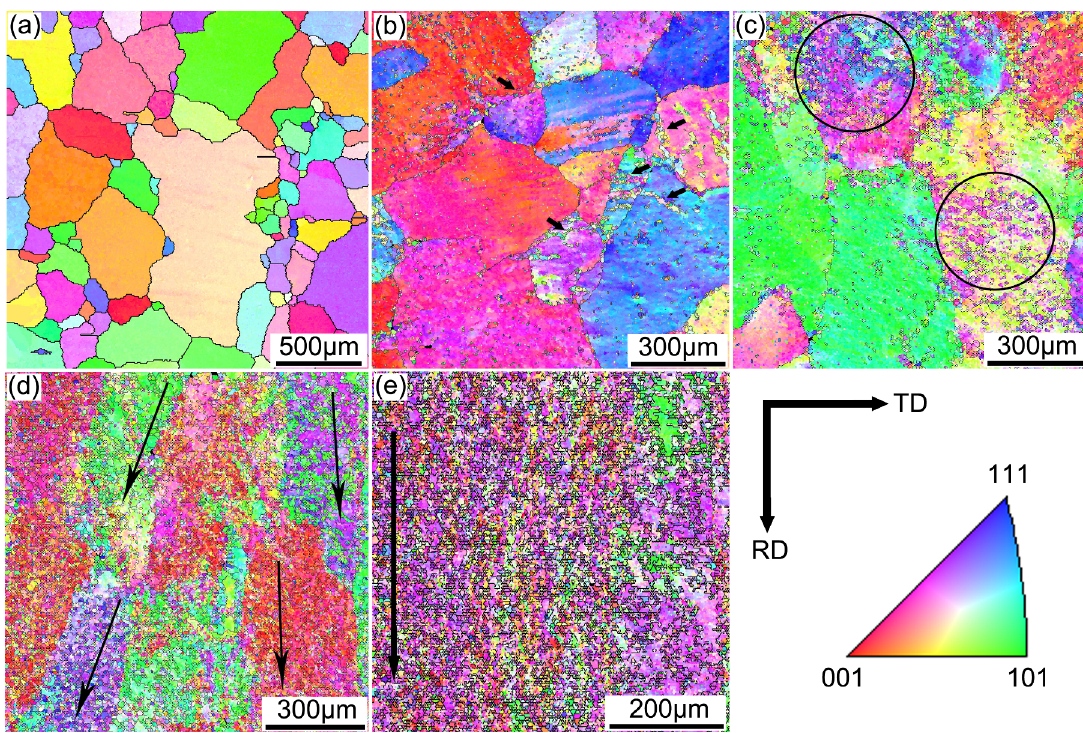
Figure 5. EBSD maps of the samples (a) 0, (b) HR30, (c) HR50, (d) HR+CR70 and (e)